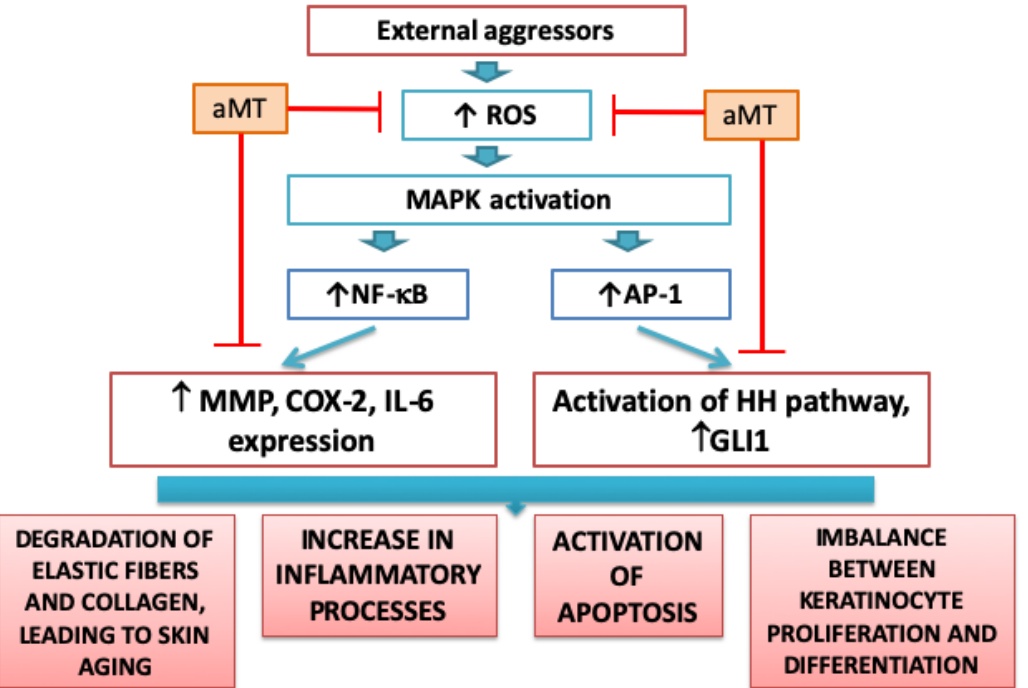
Figure 3. External aggressors increase ROS production in the skin, which induces downstream MAPK signaling pathways, leading to an activation of NF-  B and AP-1. Activation of the NF-  B pathway induces the expression of MMPs, COX-2, and IL-6, among others. This leads to an increase in inflammatory processes and activates proteases that weaken the structure of the skin. Activation of the HH pathway through the involvement of GLI1 increases apoptosis and leads to an imbalance between keratinocyte proliferation and